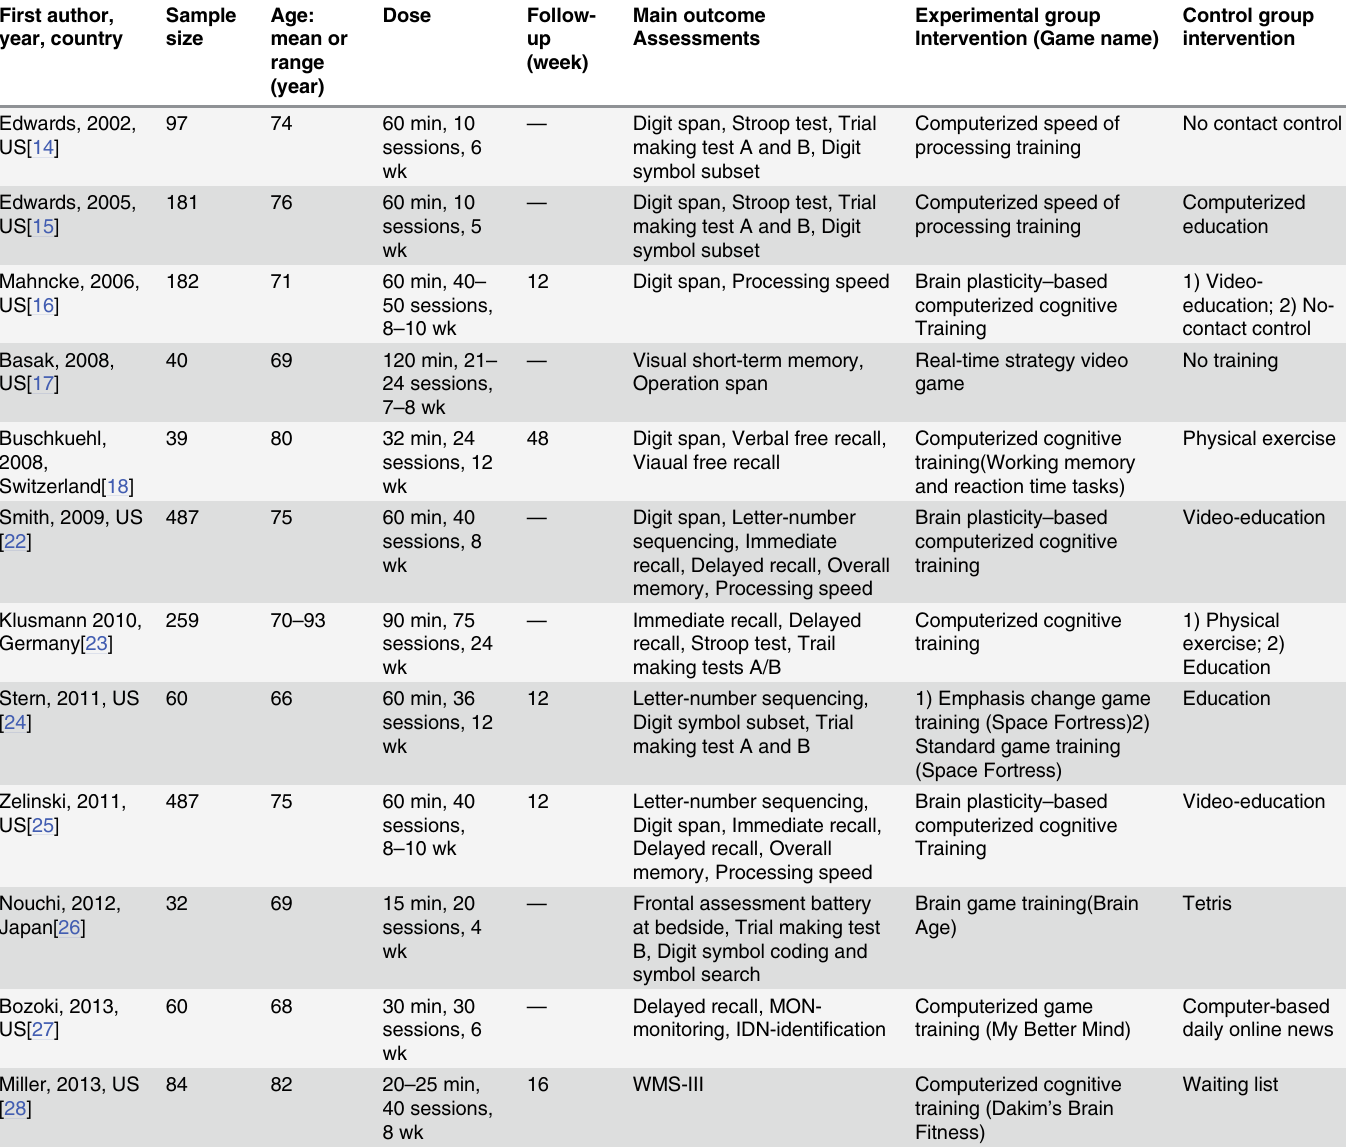
Table 1. Characteristics of included